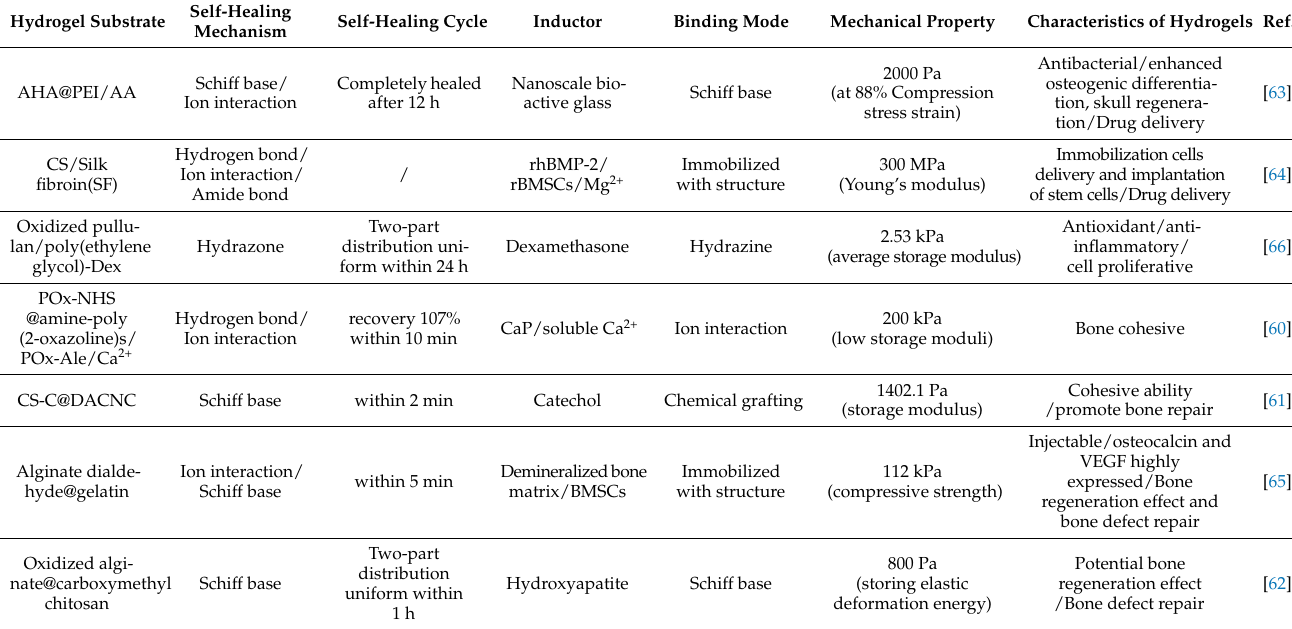
Table 1. Self-healing hydrogel for bone